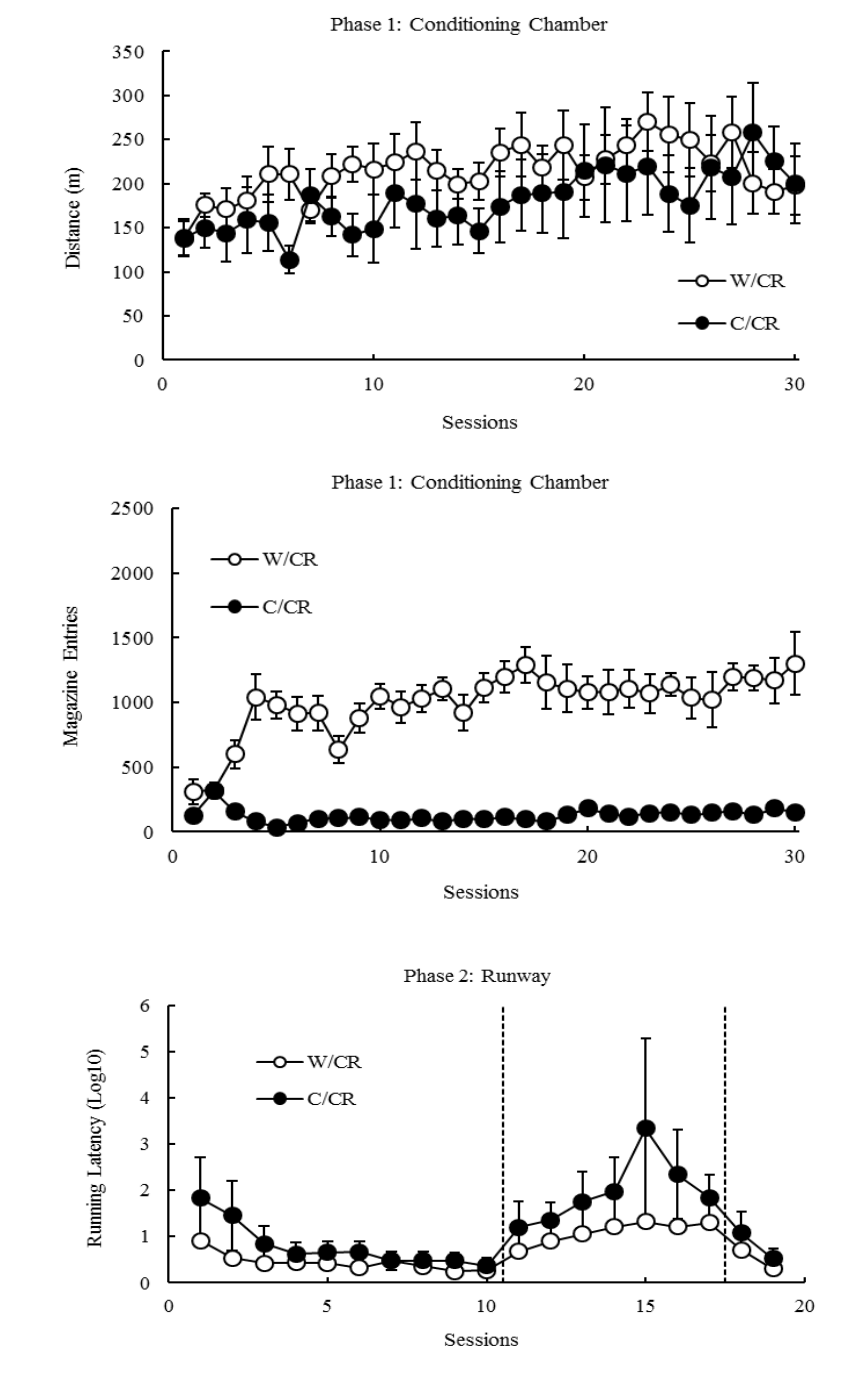
Figure 3. Means (±SEMs) ran in the activity wheel (in meters) for the experimental (W/CR) and control (C/CR) groups (top panel) and magazine entries (middle panel) during initial training with FT 60 s in the conditioning chambers, and running latency (in log 10 seconds) during acquisition, extinction, and reacquisition in the runway (bottom panel). W: access to a wheel during intermittent reinforcement; C: massed-food control; CR: continuous reinforcement. Error bars were always included, but they are difficult to visualize in some